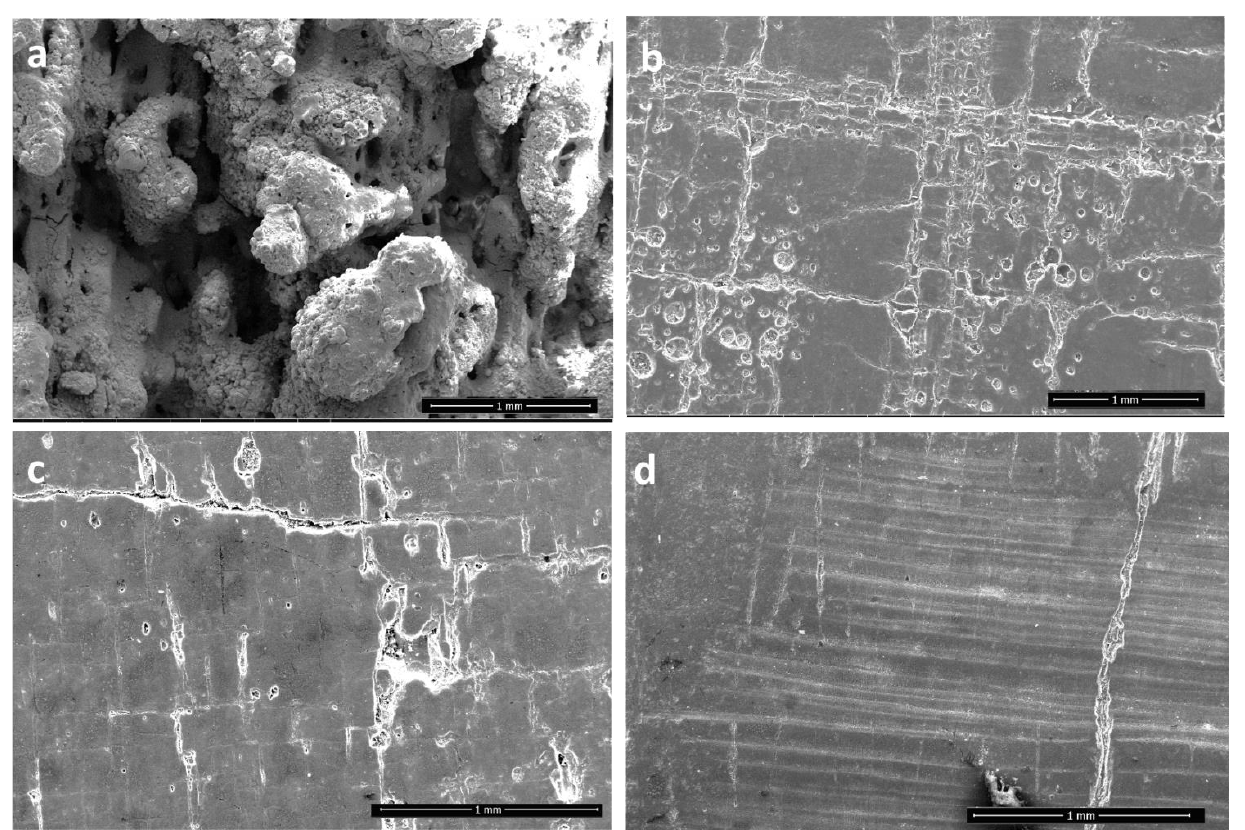
Figure 12. Surface morphology of ( a ) Alumina wt % 80, silicon carbide wt % 20 (unpolished); ( b ) alumina wt % 90, silicon carbide wt % 10 (polished); ( c ) alumina wt % 98, silicon carbide wt % 2 ( b ) alumina wt% 90, silicon carbide wt% 10 (polished); ( c ) alumina wt% 98, silicon carbide wt% (polished); ( d ) alumina wt % 99.5, silicon carbide wt % 0.5 at 200 W laser power (polished). 2 (polished); ( d ) alumina wt% 99.5, silicon carbide wt% 0.5 at 200 W laser power